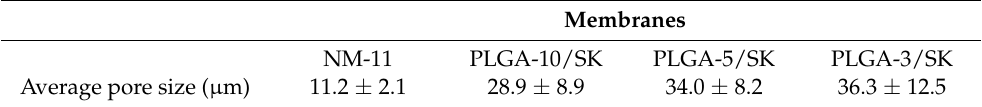
Figure 2. Filter configurations and morphologies used for isolation of CSCs (CICs) from colon carcinoma cells. ( A ) Outline photos of PLGA-3/SK ( i ), PLGA-5/SK ( ii ), PLGA-10/SK ( iii ), and NM-11 ( iv ) filters. Morphologies of PLGA-3/SK ( v , ix ), PLGA-5/SK ( vi , x ), PLGA-10/SK ( vii , xi ), and NM-11 ( viii ) filters from the top views ( v – viii ) and cross-sectional views ( ix – xi ) measured by SEM. The scale bar indicates 100 µ m ( v – x ) and 300 µ m ( xi ). ( B ) 3D surface image of PLGA-3/SK ( i ), PLGA-5/SK ( ii ), PLGA-10/SK ( iii ), and NY-11 ( iv ) filters analyzed using PRIMOS Lite. Table 2. Characterization of membranes used for membrane filtration and migration